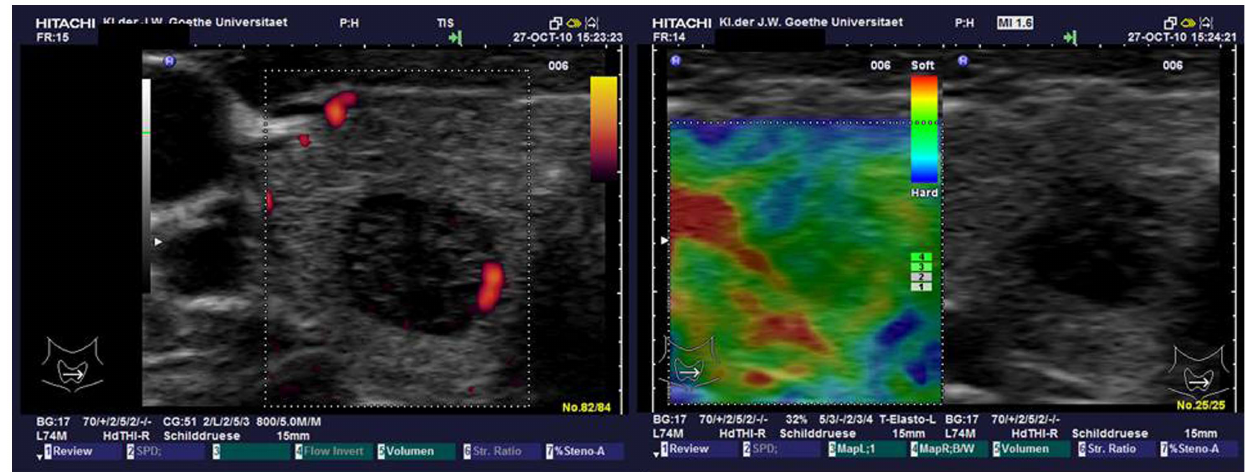
Figure 1. Example of TIRADS and SE of thyroid adenoma: 10 mm nodule in the right thyroid gland classified as TIRADS 4 (consistent with malignancy) in the left image and SE 2 (predominantly green = soft; consistent with benign nodule) in the right image. Histology revealed a benign follicular thyroid adenoma.